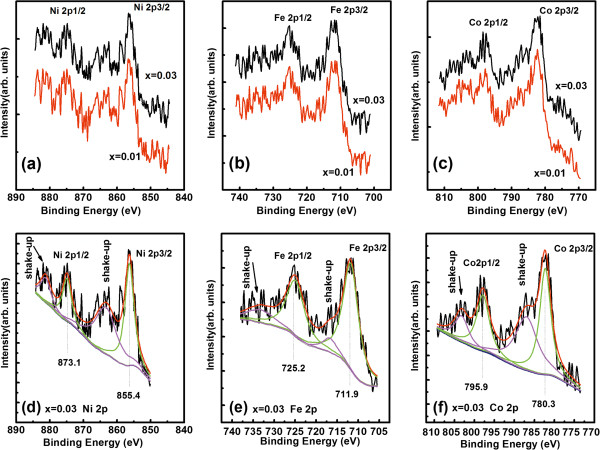
TM 2p core level XPS spectra for TM-doped TiO2 thin films. High-resolution XPS spectra of Ni 2p(a), Fe 2p(b), and Co 2p(c) core level for TM-doped TiO2 films. Experimental and fitted XPS spectra of Ni 2p(d), Fe 2p(e), and Co 2p(f) core level for Ti0.97TM0.03O2 films.